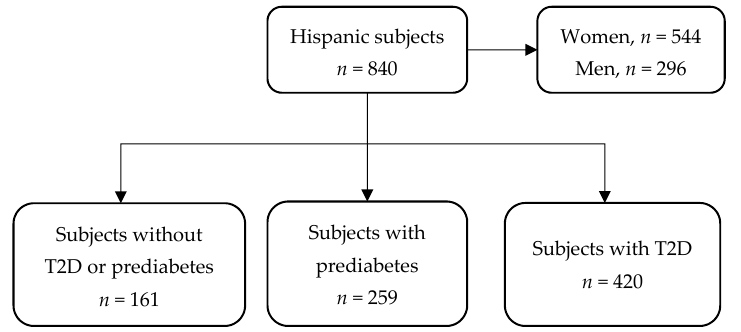
Figure 1. Study population flow-chart.